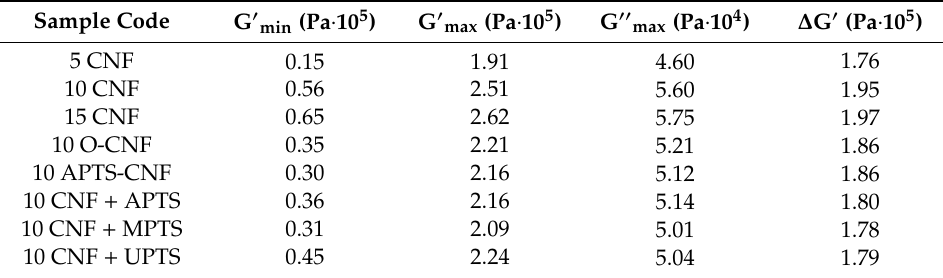
Table 2. Dynamic measurements